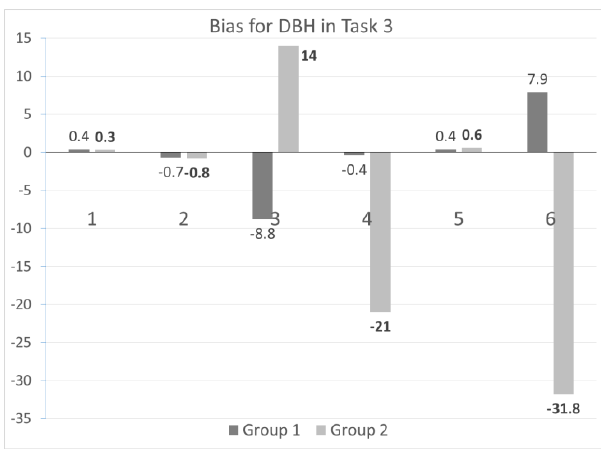
Figure 5. The bias of tree DBH values for all trees in task